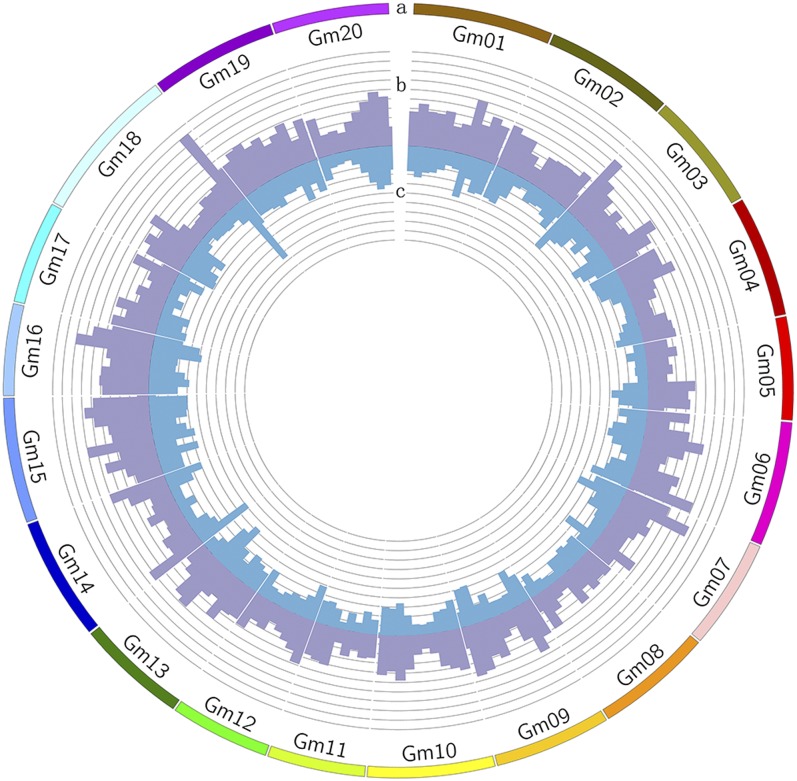
Distribution of INDELs identified between Williams 82 and Hedou 12 along 20 chromosomes. Circular representation of the distribution of insertions and deletions in the soybean genome. (A) The 20 chromosomes of Glycine max (Gm), (B) The number of deletions in sliding windows of 5 Mb in each chromosome of G. max, (C) The number of insertions in sliding windows of 5 Mb in each chromosome of G. max. Scale is 40 INDELs between neighbor concentric circles.